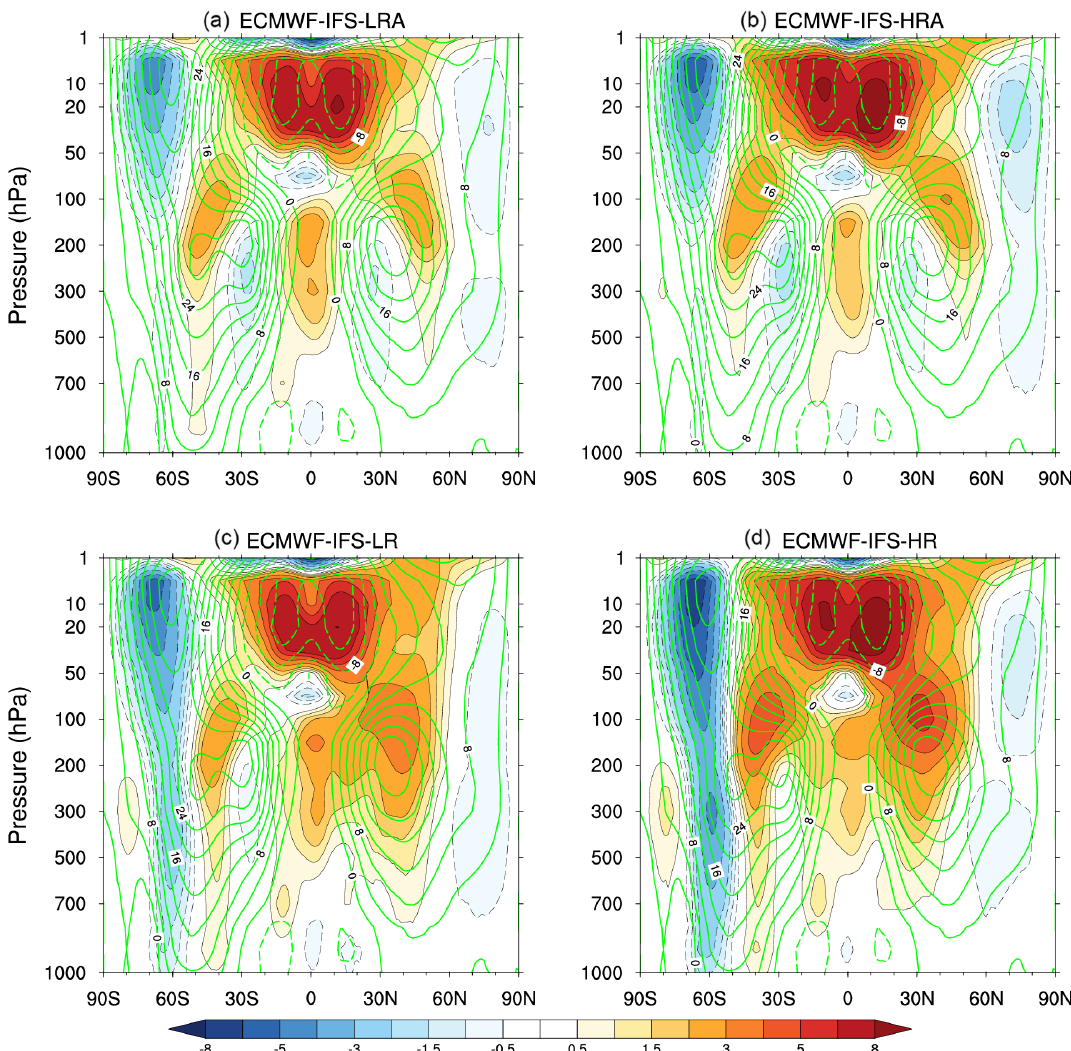
Figure 11. Mean bias in zonal-mean wind in (a–b) highresSST-present and (c–d) hist-1950 relative to ERA-Interim for the period 1981–2010 (shaded) and the climatological mean from ERA-Interim